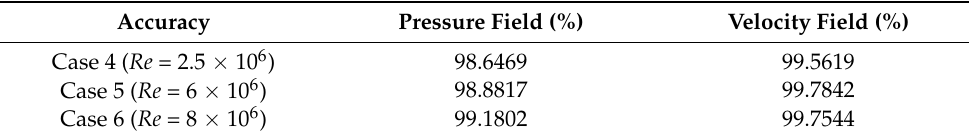
Figure 16. The true (CFD) and predicted flow fields of three cases under the extended Reynolds numbers: ( a ) case 4: NACA9712, AOA = 0°, Re = 2.5 × 10 6 ; ( b ) case 5: NACA2412, AOA = 5°, Re = 6 × 10 6 ; ( c ) case 6: NACA6212, AOA = 3°, Re = 8 × 10 6 . Table 9. Accuracy for three cases under the extended Reynolds